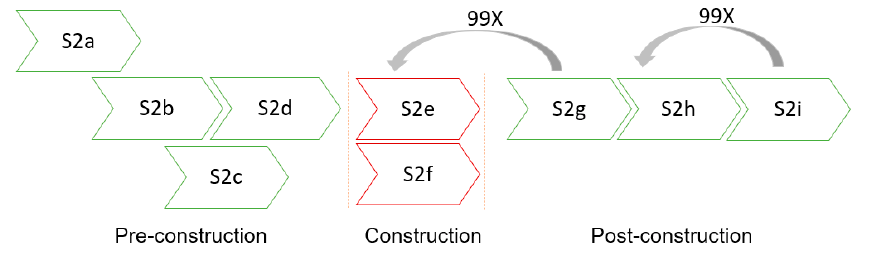
Figure 3. The process map for Scenario 1.